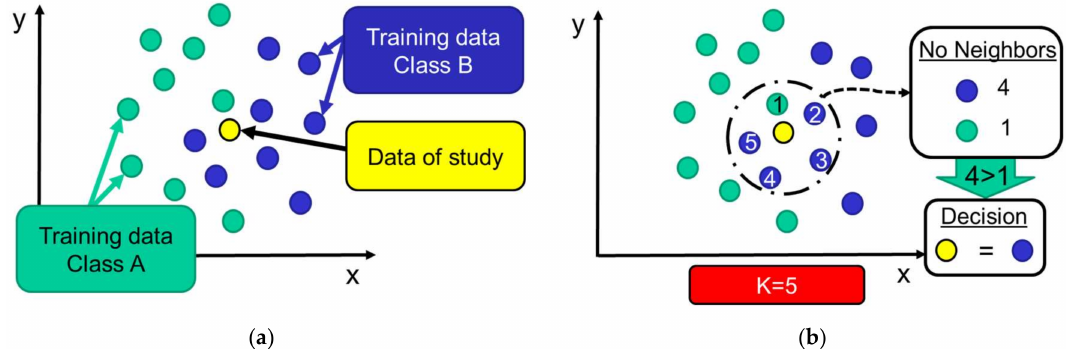
Figure 6. Operation of k -NN classifier: ( a ) the data under study is located among the training patterns aiming at finding the k nearest neighbor (in the example k = 5); ( b ) after detecting the k nearest samples, the new sample is classified considering the ‘majority vote’ (most common class) of its